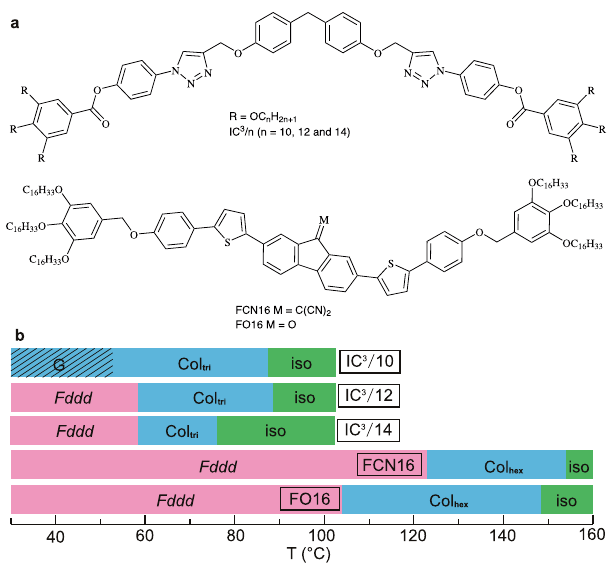
Fig. 1 Chemical formulae and phase transition temperatures of the compounds. a Chemical formulae of IC 3 /n, FCN16, and FO16. b Bar chart of phase transition temperatures of IC 3 /n, FCN16, and FO16. Table 1 Phase transition temperatures on cooling. Fig. 2 Polarized optical micrographs recorded with a full-wave ( λ ) plate. a , c , e columnar and b , d , f Fddd phases of compounds ( a , b ) IC 3 /14, ( c , d ) FCN16 and ( e , f ) FO16. Inset in a depicts two developable domains with (1) a s = + 1 disclination and (2) two + ½ disclinations, the latter indicating stiffer columns; black lines are column trajectories. Inset in b shows orientation of indicatrices of the λ -plate and the colored fans. Scale bar in b applies to all Figures. See more textures in Supplementary Section